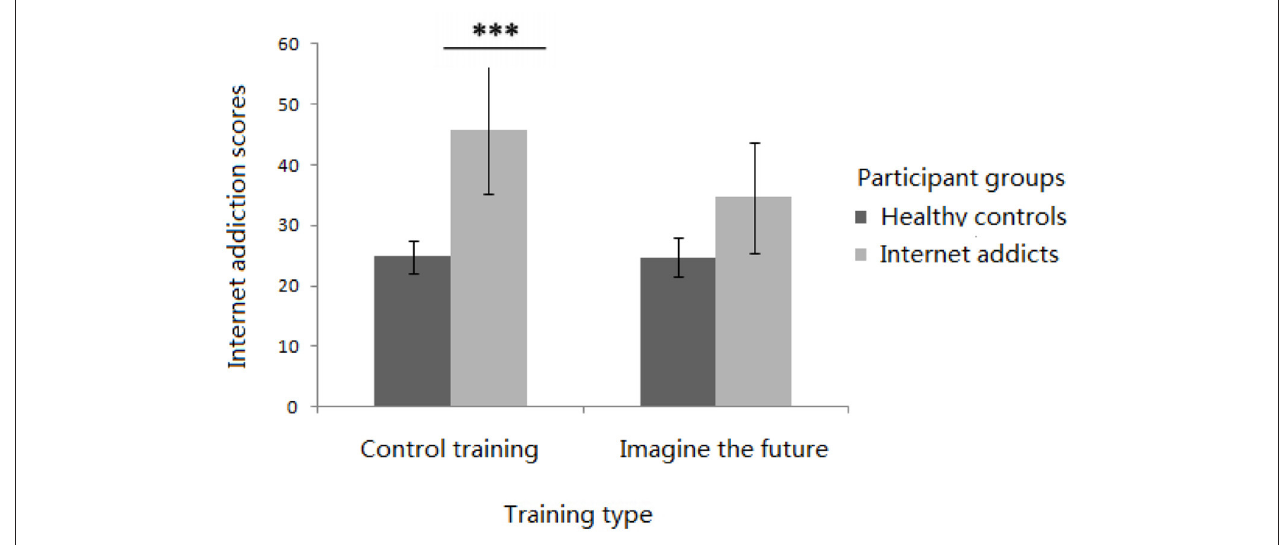
FIGURE 3 | Interaction between the participant groups and training type for Internet addiction scores (includes mean and SD; ***means p <